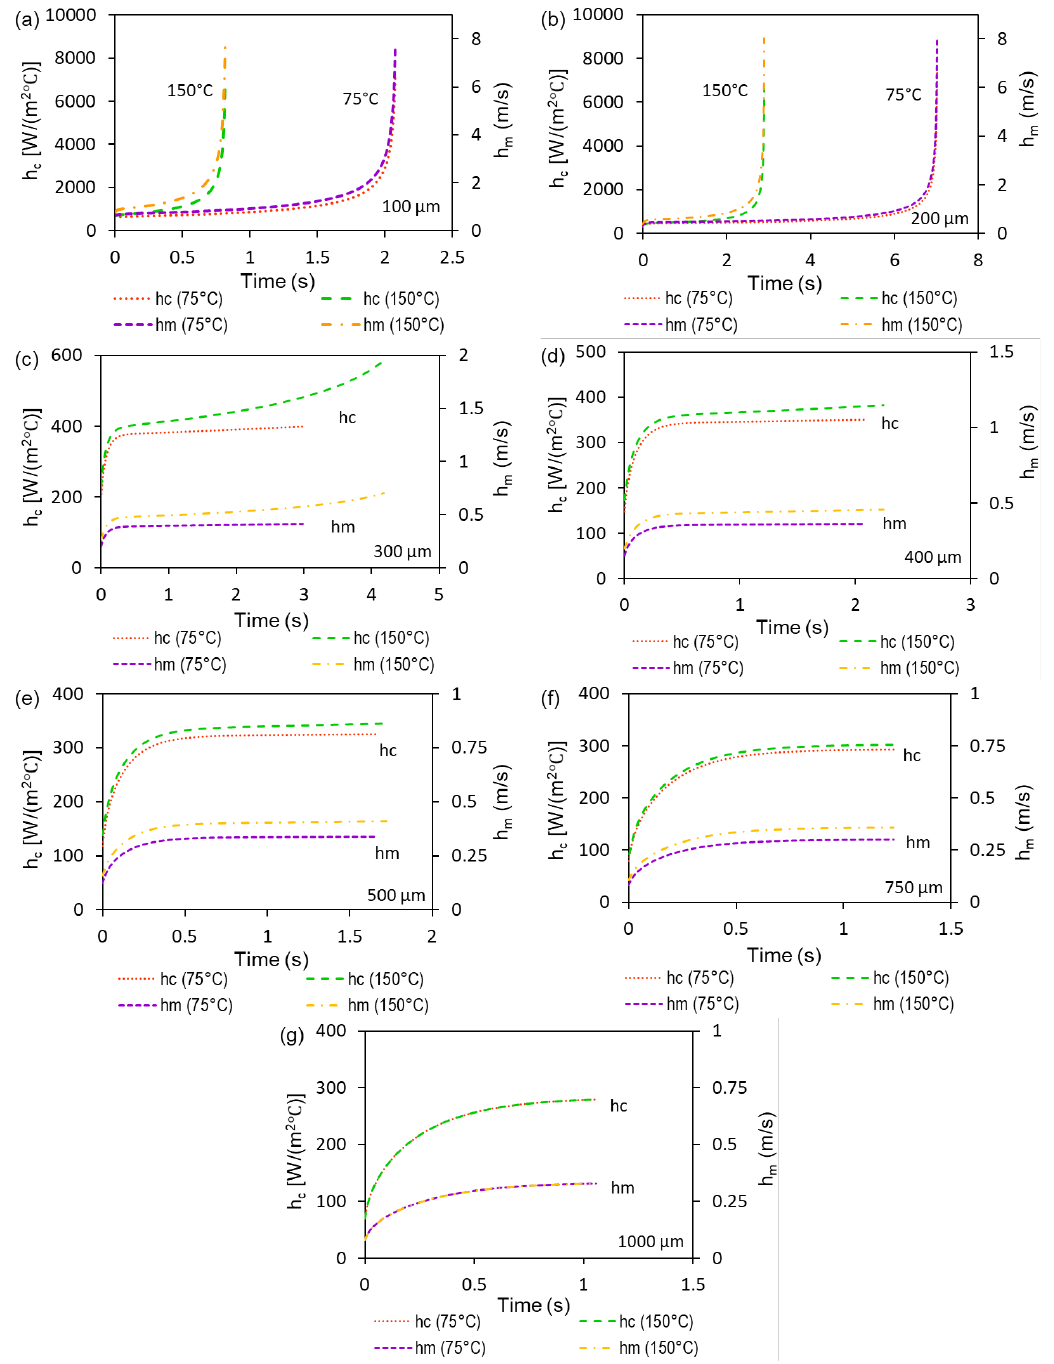
Figure 9. The heat and mass transfer coefficient of the droplets for condition 1 and 2; ( a ) 100 µm; ( b ) 200 µm; ( c ) 300 µm; ( d ) 400 µm; ( e ) 500 µm; ( f ) 750 µm; and ( g ) 1000 µm. These phenomena are also reflected in Figure 10, where the percent mass loss rates of the water droplets are presented for conditions 1 and 2. The highest percent mass loss